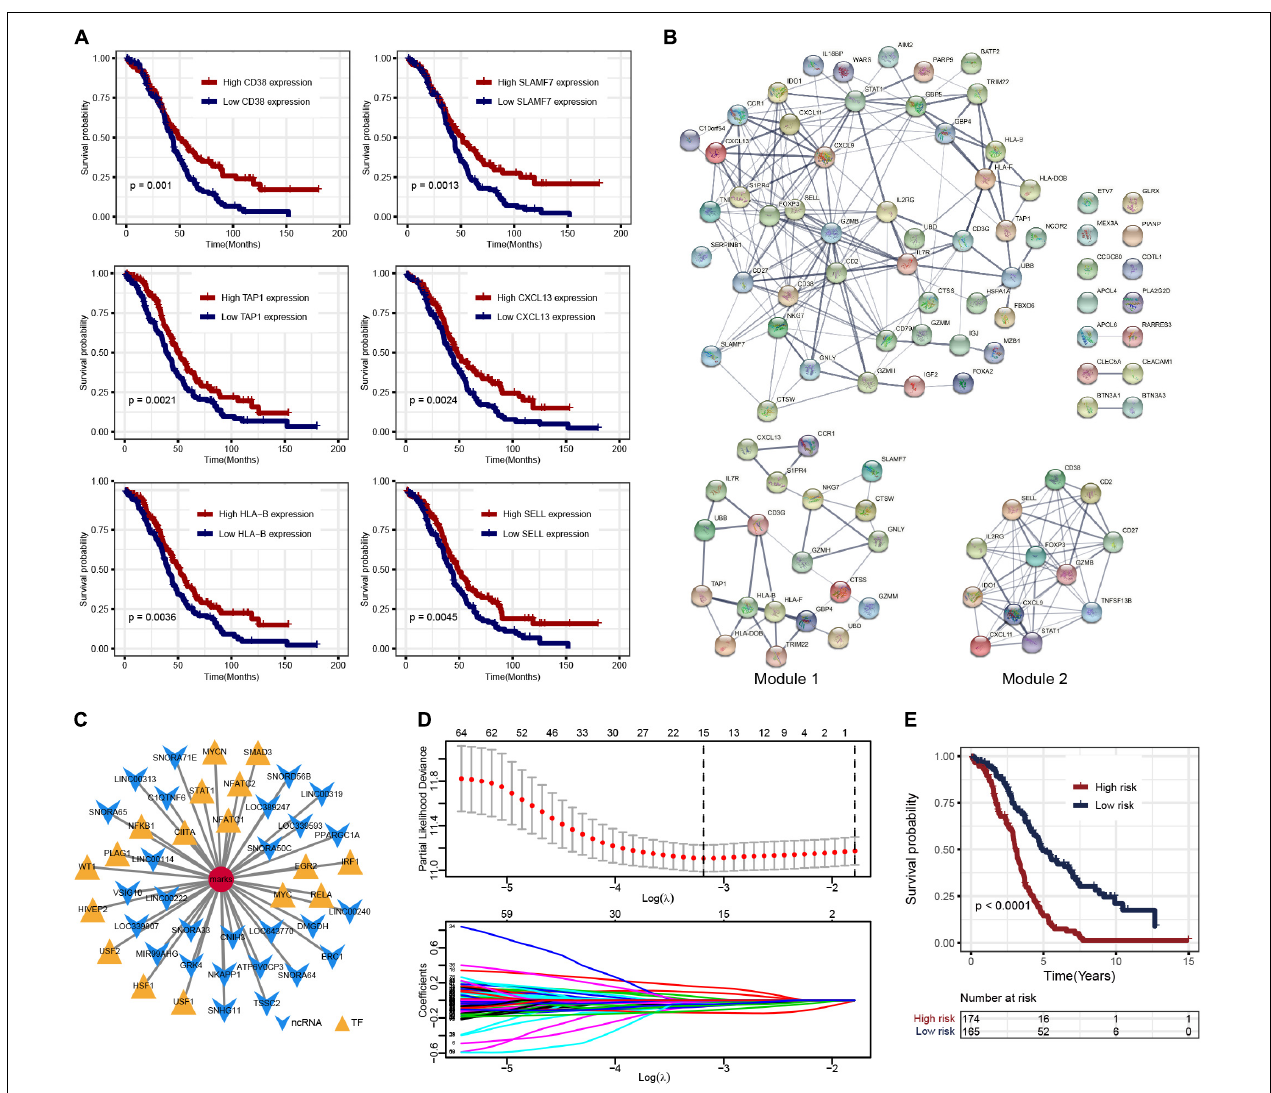
FIGURE 3 | (A) Overall survival Kaplan–Meier curves of DEGs (show top six genes). (B) The protein–protein interaction (PPI) network of prognostic genes and the two key modules. (C) Noncoding RNA (ncRNA) and transcription factor (TF)-pivot of prognostic genes; red circular mark represents 83 prognostic genes, yellow arrows represent ncRNAs, and green triangles represent TF. (D) Tenfold cross-validation for tuning parameter selection in the least absolute shrinkage and selection operator (LASSO) model. (E) The K–M survival curves show the OS based on the high- and low-risk